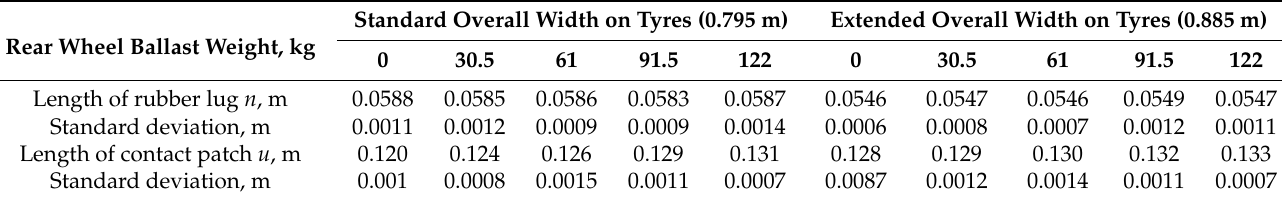
Table 8. Dimensions of tyre contact patch at various rear wheel ballast weights.